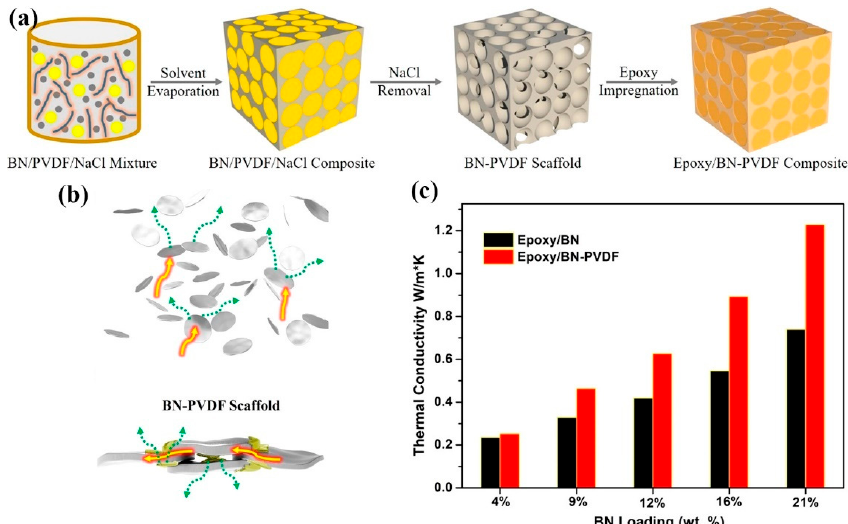
Figure 12. ( a ) Schematic diagram for the fabrication of the boron nitride (BN)-PVDF scaffolds and epoxy / BN-PVDF composites. ( b ) The constructed BN pathway held together by PVDF adhesive. ( c ) λ of epoxy / BN-PVDF composites (reproduced with permission from [27]).